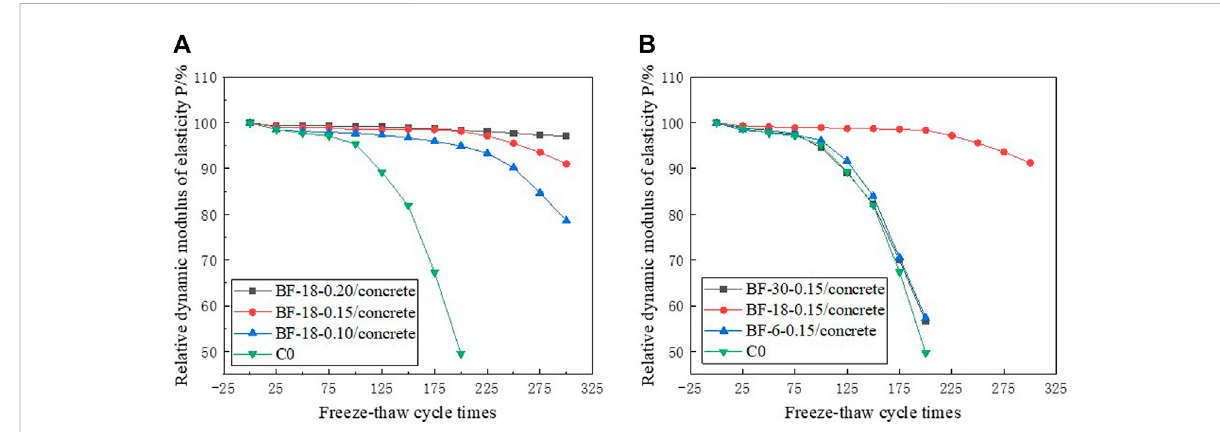
FIGURE 11 The relative dynamic modulus of BFRC varies with the number of freeze-thaw cycles under different basalt fi ber volume content and fi ber length (Li et al., 2019b) (A) Different volume content of basalt fi ber (B) Different fi ber